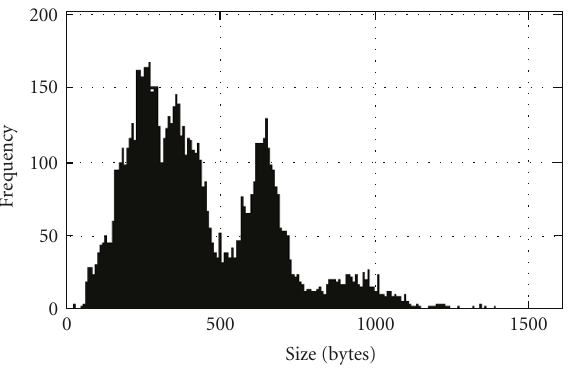
Figure 6: Distribution of slice sizes for the encoded video